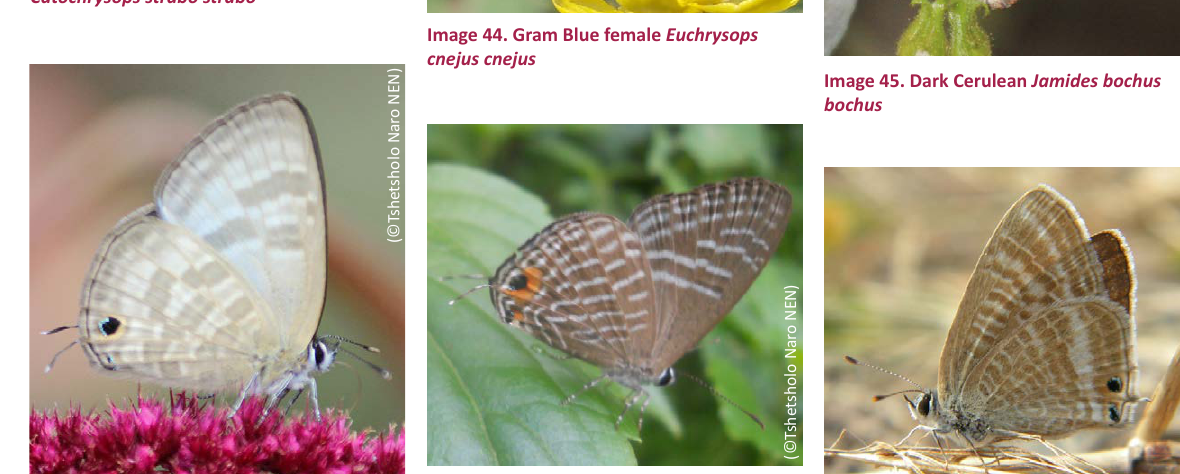
Image 47. Glistening Cerulean Jamides elpis pseudoelpis